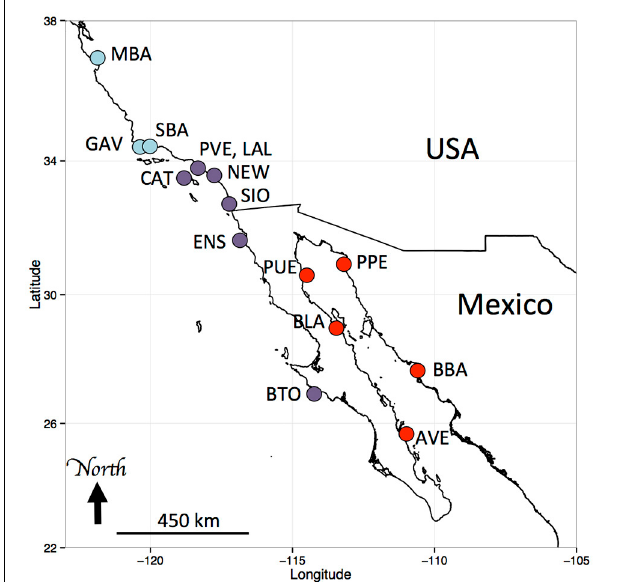
FIGURE 1 | Sampling locations of Hypsoblennius spp. Blue and purple dots indicate Pacific coast locations (central and southern California, respectively), red dots indicate Sea of Cortez locations. MBA, Monterey Bay, GAV, Gaviota; SBA, Santa Barbara; CAT, Santa Catalina Island;